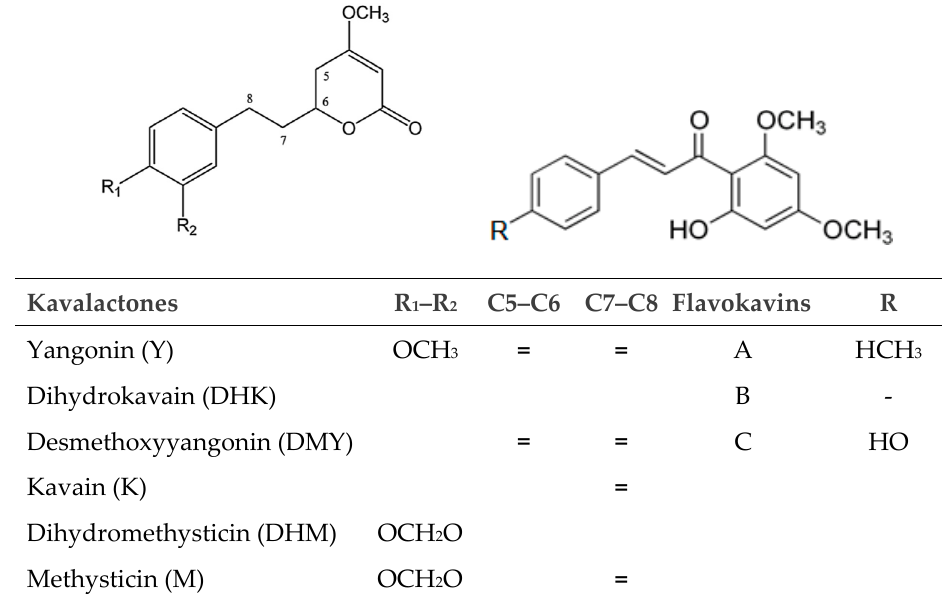
Figure 1. Chemical structure of kavalactones and flavokavins ( = : presence of double bond).